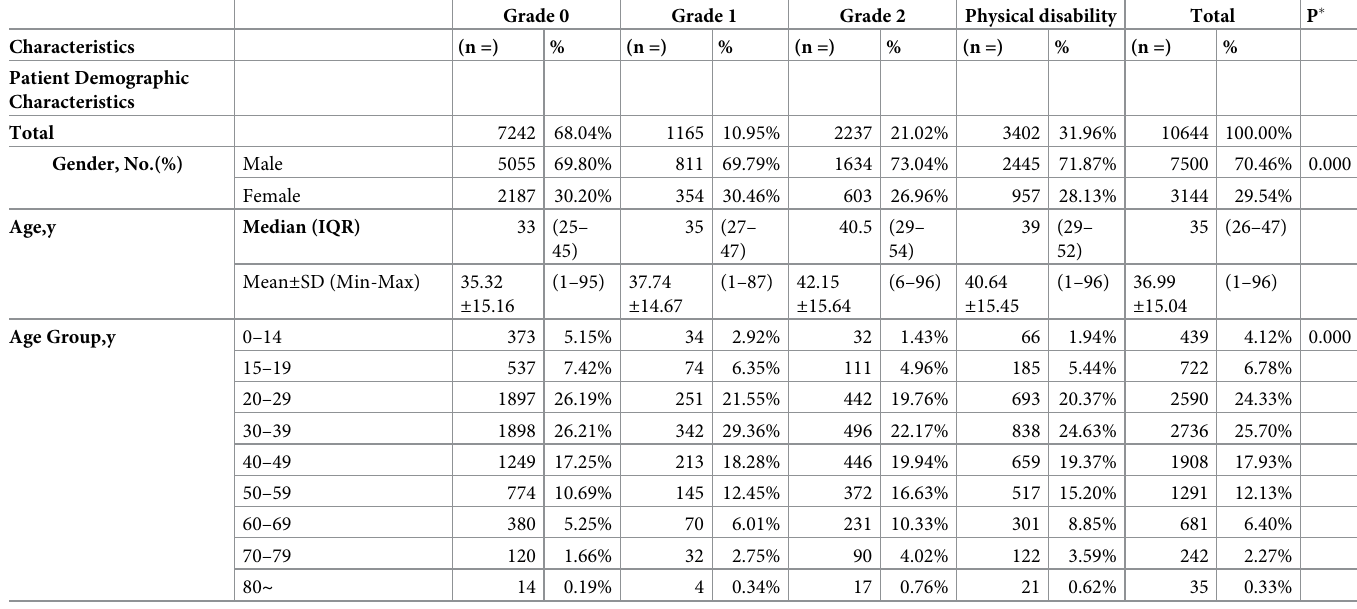
Table 1. Characteristics of New detected Leprosy Cases in Yunnan, China from 1990–2019, Grouped by Physical Disablity